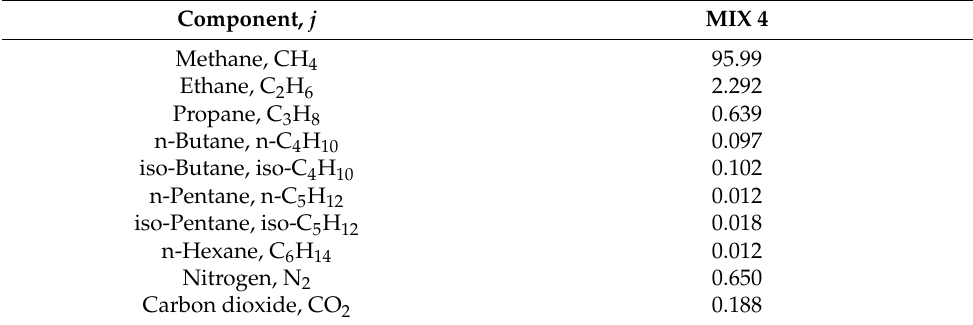
Table 4. Molar composition of the investigated gas mixture.